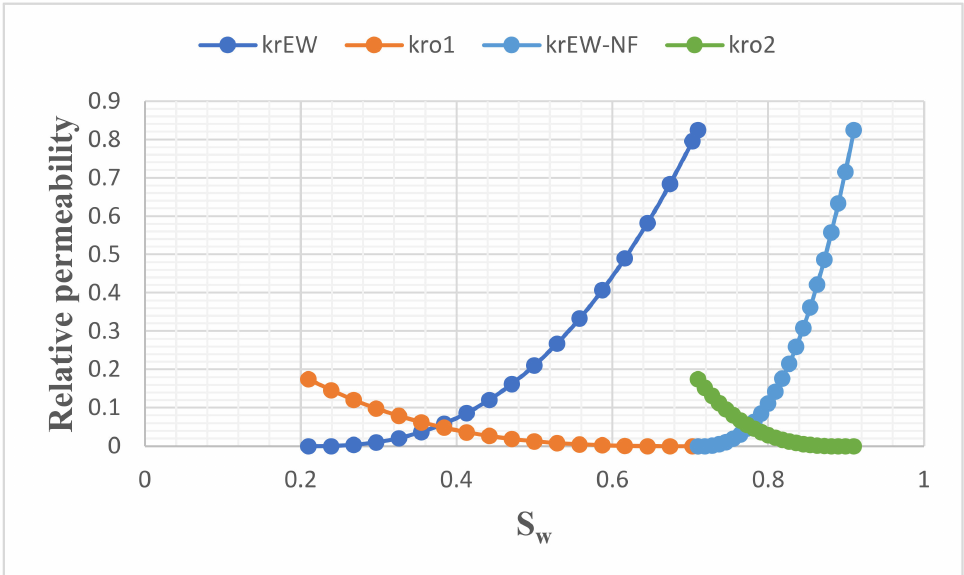
Figure 21. Relative permeability curves for EW and EW-NF